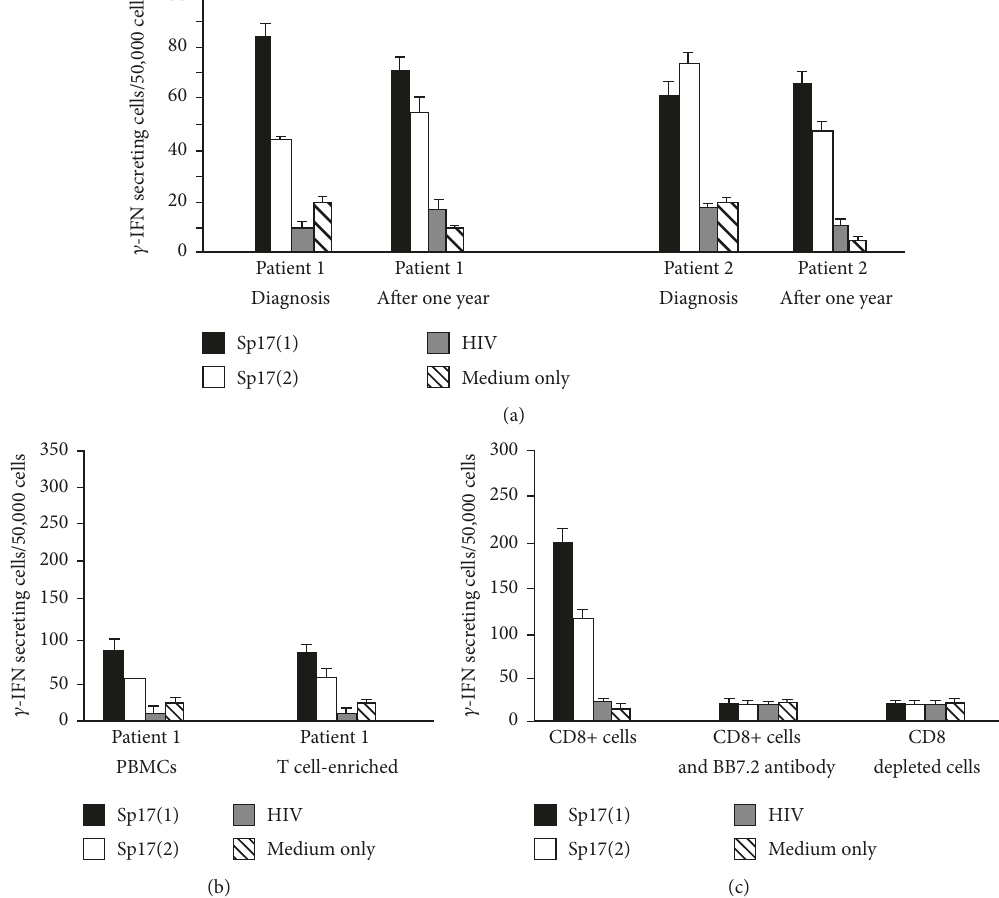
Figure 1: 𝛾 -IFN responses of patients 1 and 2 to Sp17 peptides. In (a) peripheral blood mononuclear cells (PBMCs) obtained from patients 1 and 2 at time of diagnosis after one year from start of treatment were maintained in short tern culture. A significant 𝛾 -IFN response to peptides Sp17(1) and Sp17(2) was observed in cells from both patients obtained at both time points ( 𝑃 < 0.05 ). No significant response was detected in cultures stimulated by the HIV peptide or containing medium only. (b) PBMCs from patient 1 after three rounds of peptide stimulation expanded in response to Sp17(1) and Sp17(2) peptides. (c) PBMCs from patient 1 were either enriched for CD8-positive cells using anti-CD8 antibody-coated magnetic beads or incubated with an anti-HLA-A ∗ 0201 monoclonal antibody (BB7.2). A significant 𝛾 -IFN response was observed only in the culture containing the CD ∗ -positive cells in the absence of anti-MHC class I ( 𝑃 < 0.05 ). No significant responses were detected in the control cultures or the irrelevant peptides. The results are mean +/ − SD and were obtained from triplicate ELISPOT cultures.